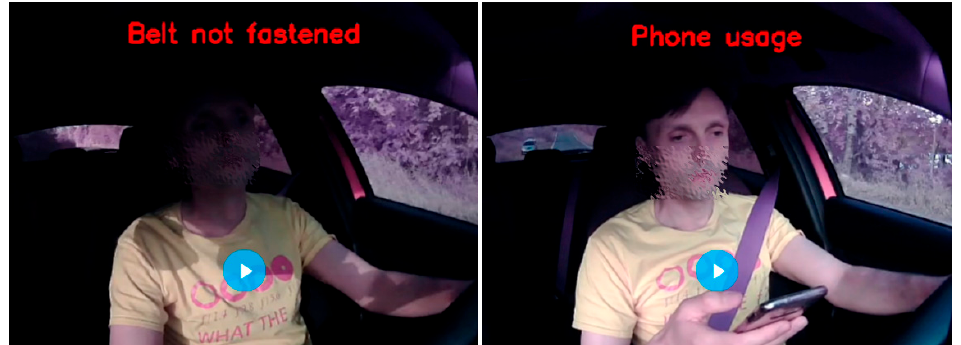
Table 3. Developed framework evaluation.